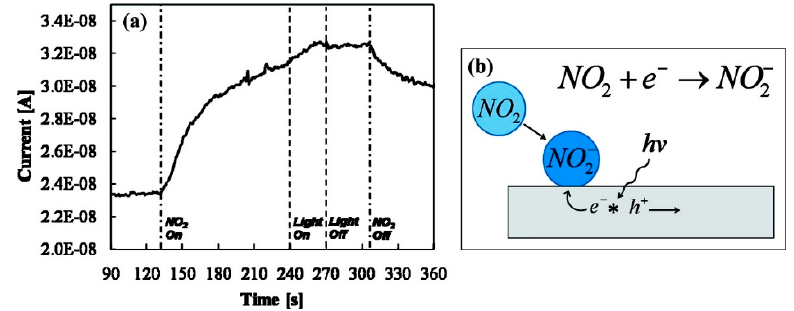
Figure 28. ( a ) The effect of light irradiation on the dynamic response of CuO nanowire (NW) sensor to 100 ppm NO 2 at room temperature; ( b ) Proposed mechanism. Reproduced with permission from [61].